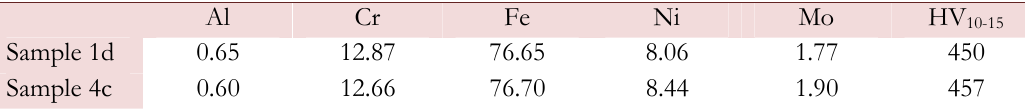
M ATERIAL MICROSTRUTURE